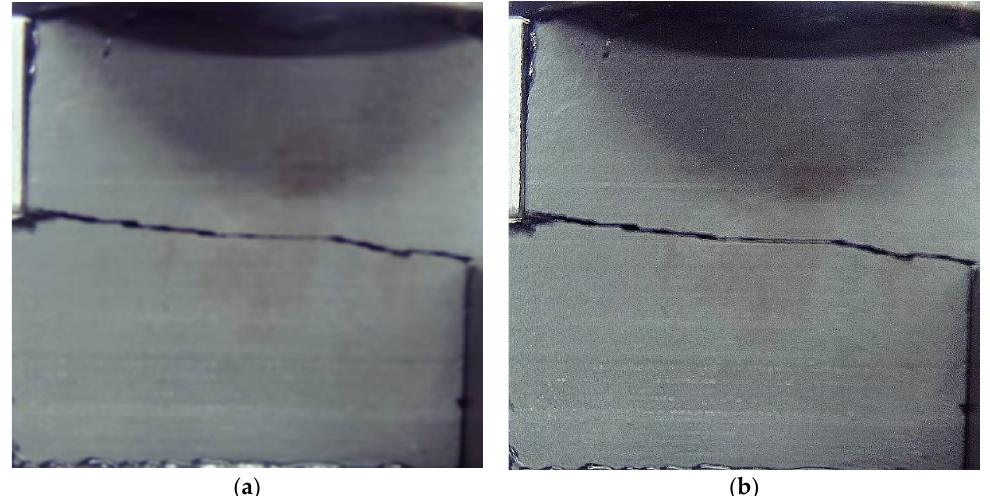
Figure 6. Comparison of images before and after filtering. ( a ) Before median filtering. ( b ) After median filtering.